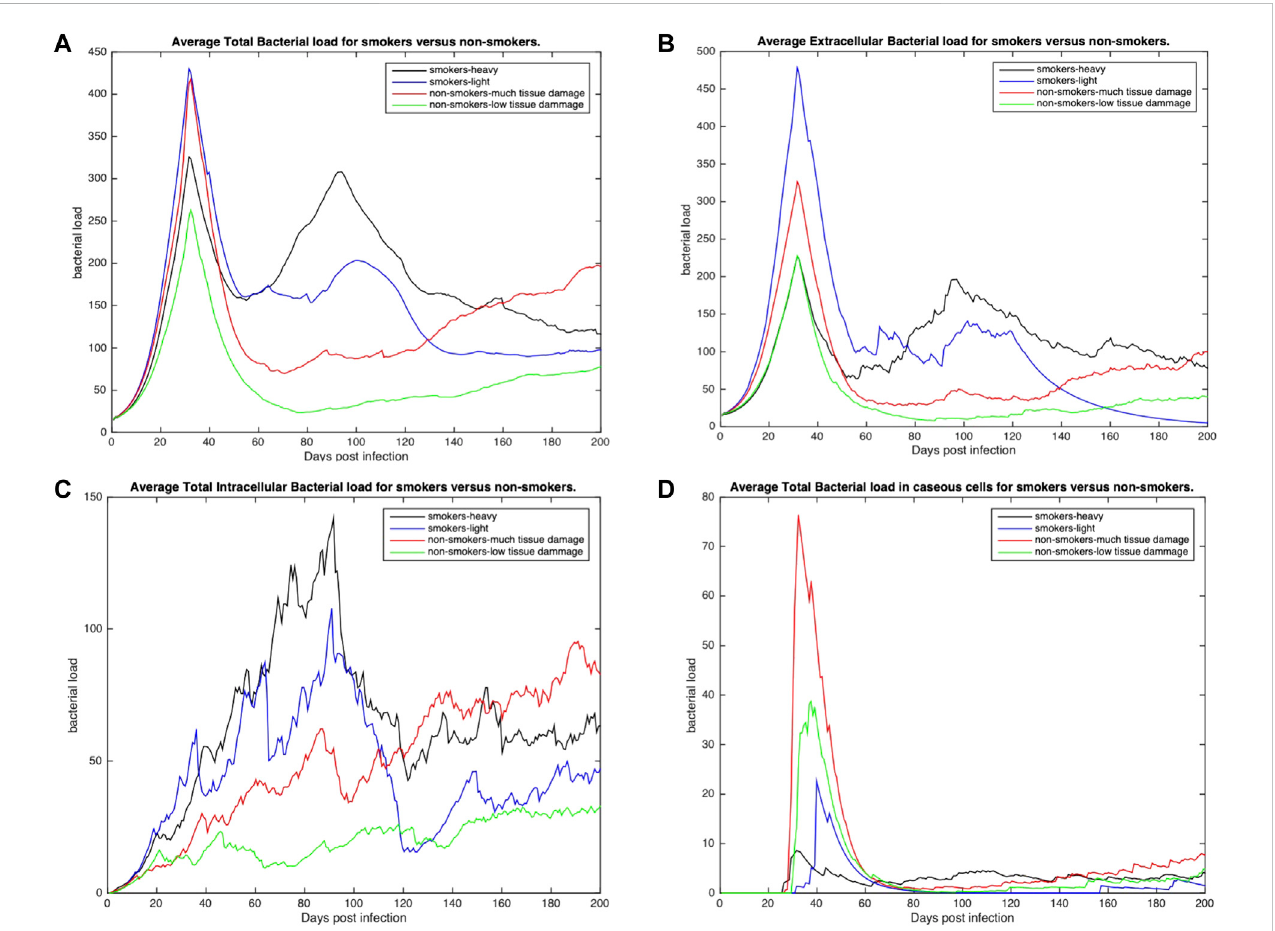
FIGURE 3 The distribution of average bacterial loads across three different environments: extracellular, intracellular and caseous cells. (A) Average total bacterial load for each group. (B) Average extracellular bacterial load across all groups (includes any bacteria in necrotic or damaged tissue). (C) Average intracellular bacterialload;valuesrepresenttheaverageperinfectedcellacrossallgroups. (D) Averagebacterialloadincaseoustissues.Allpro fi lesstatisticallysigni fi cantly different using K-S test with p <